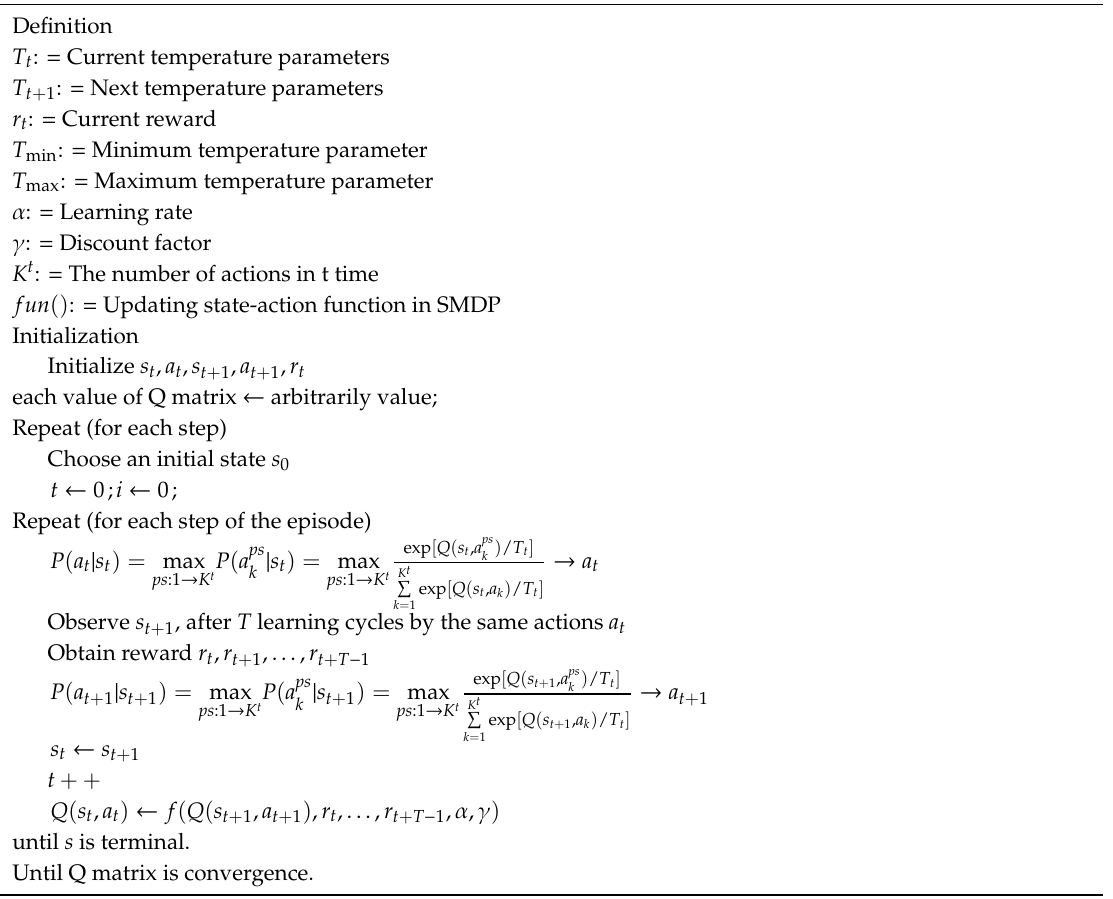
Algorithm 1: SSAQ algorithm for